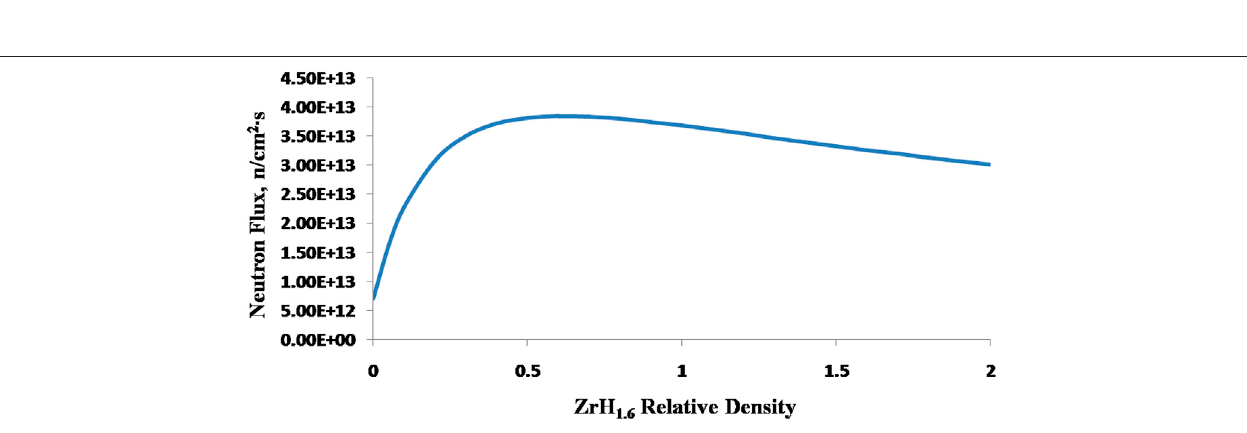
Frontiers in Energy Research |